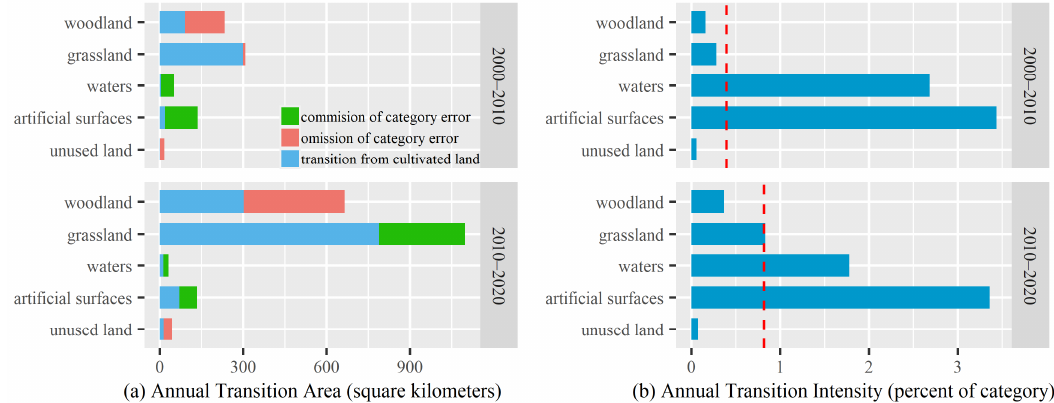
Figure 17. Intensity analysis for cultivated land loss in the middle reaches. The transition size along with hypothetical map errors ( a ); transition intensities ( b ). The red, vertical dashed lines indicate the uniform intensities.